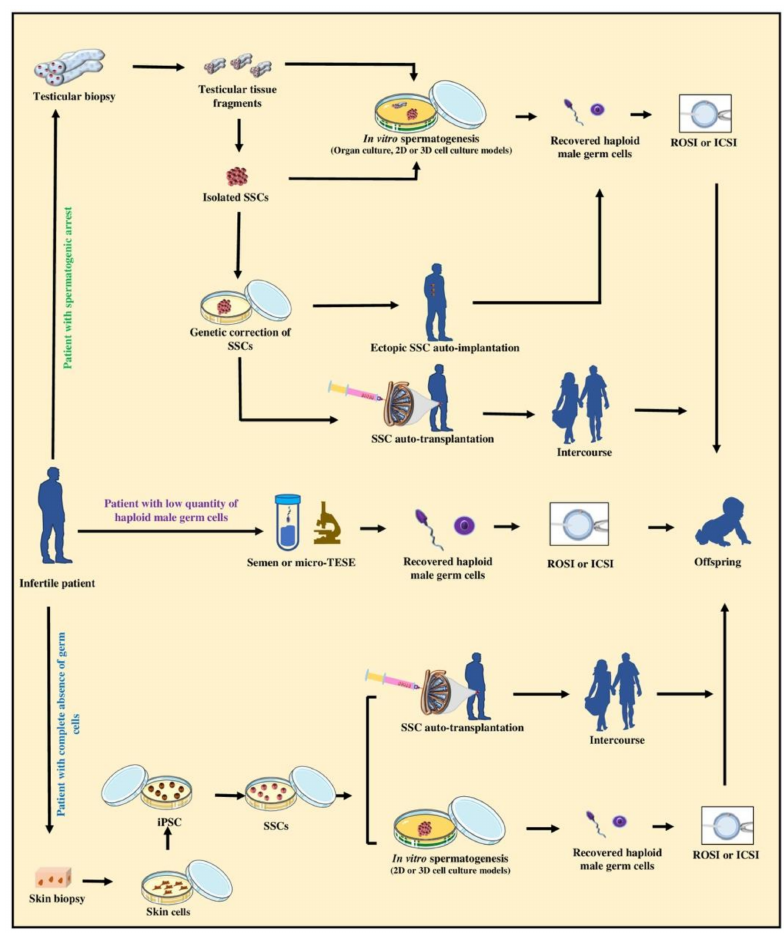
Figure 4. Schematic representation of standard, experimental, and theoretical options for upholding the biological fatherhood of adult infertile patients. The standard practice for upholding the biological fatherhood of an adult infertile patient is to use sperm from ejaculated semen or to use testicular sperm obtained by microsurgical extraction (TESE) for in vitro fertilization such as using intracytoplasmic sperm injection (ICSI) or round spermatid injection (ROSI). However, this option is applicable only when the patient’s testis contains haploid male germ cells, such as in men with obstructive azoospermia. When infertility is due to spermatogenic arrest, testicular biopsies containing SSCs can be potentially obtained and used either for in vitro spermatogenesis (i.e., organotypic culture, 2D, or 3D cell culture models) in optimized culture conditions to produce haploid male germ cells. Moreover, theoretically genetic correction of isolated SSCs can also be applied in vitro before SSCs can be used for ectopic SSC auto-implantation or auto-transplantation into the patient testis to regenerate spermatogenesis and possibly lead to natural fertility. If the testis of the infertile patients does not contain normal germ cells, skin biopsies can be collected from the patient to theoretically produce induced pluripotent stem cells (iPSC), followed by di ff erentiation of iPSC into SSCs. Such SSCs can then be potentially used for in vitro spermatogenesis (i.e., 2D or 3D cell culture models) to produce haploid male germ cells that can be used to fertilize eggs by ICSI or ROSI. Alternatively, auto-transplantation of SSCs can be potentially used to regenerate spermatogenesis and possibly natural fertility. It is important to emphasize that extensive further research is required to fully examine the various technical, safety, ethical, and legal aspects of the proposed experimental and theoretical options depicted here before they can be recommended for experimental or potential clinical